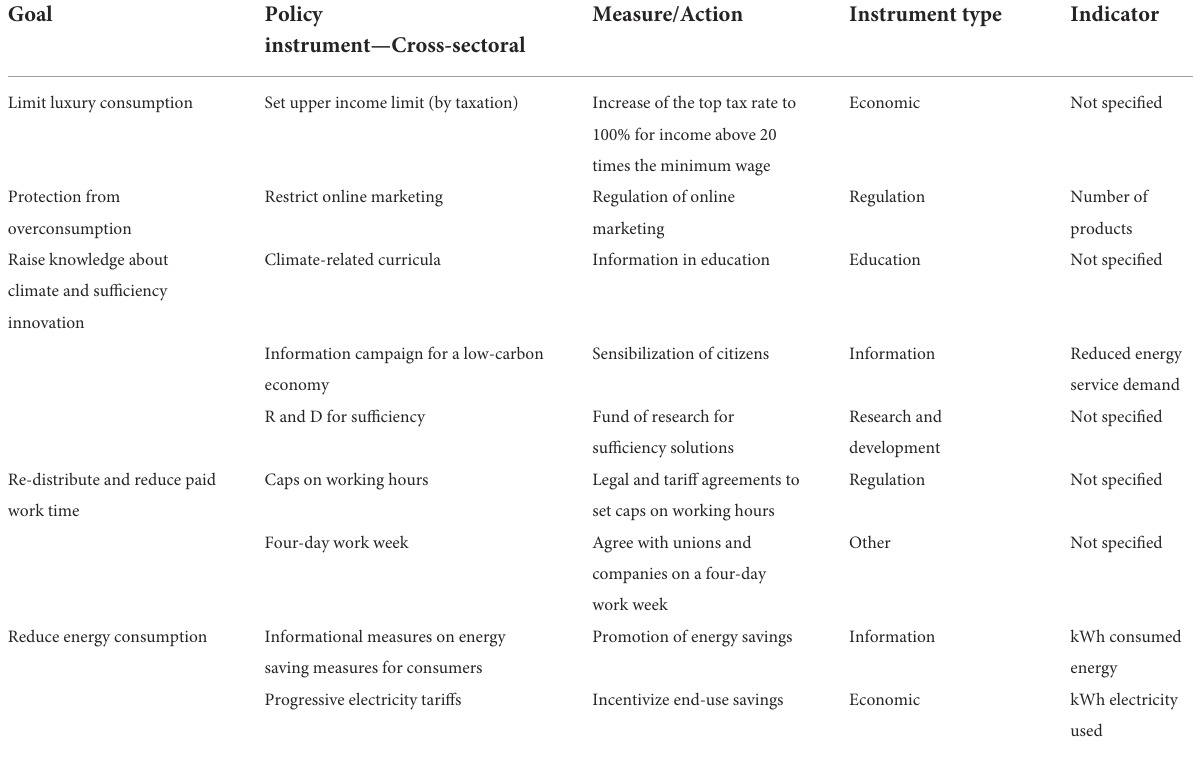
TABLE 2 Examples of cross-sectoral energy sufficiency policies for selected